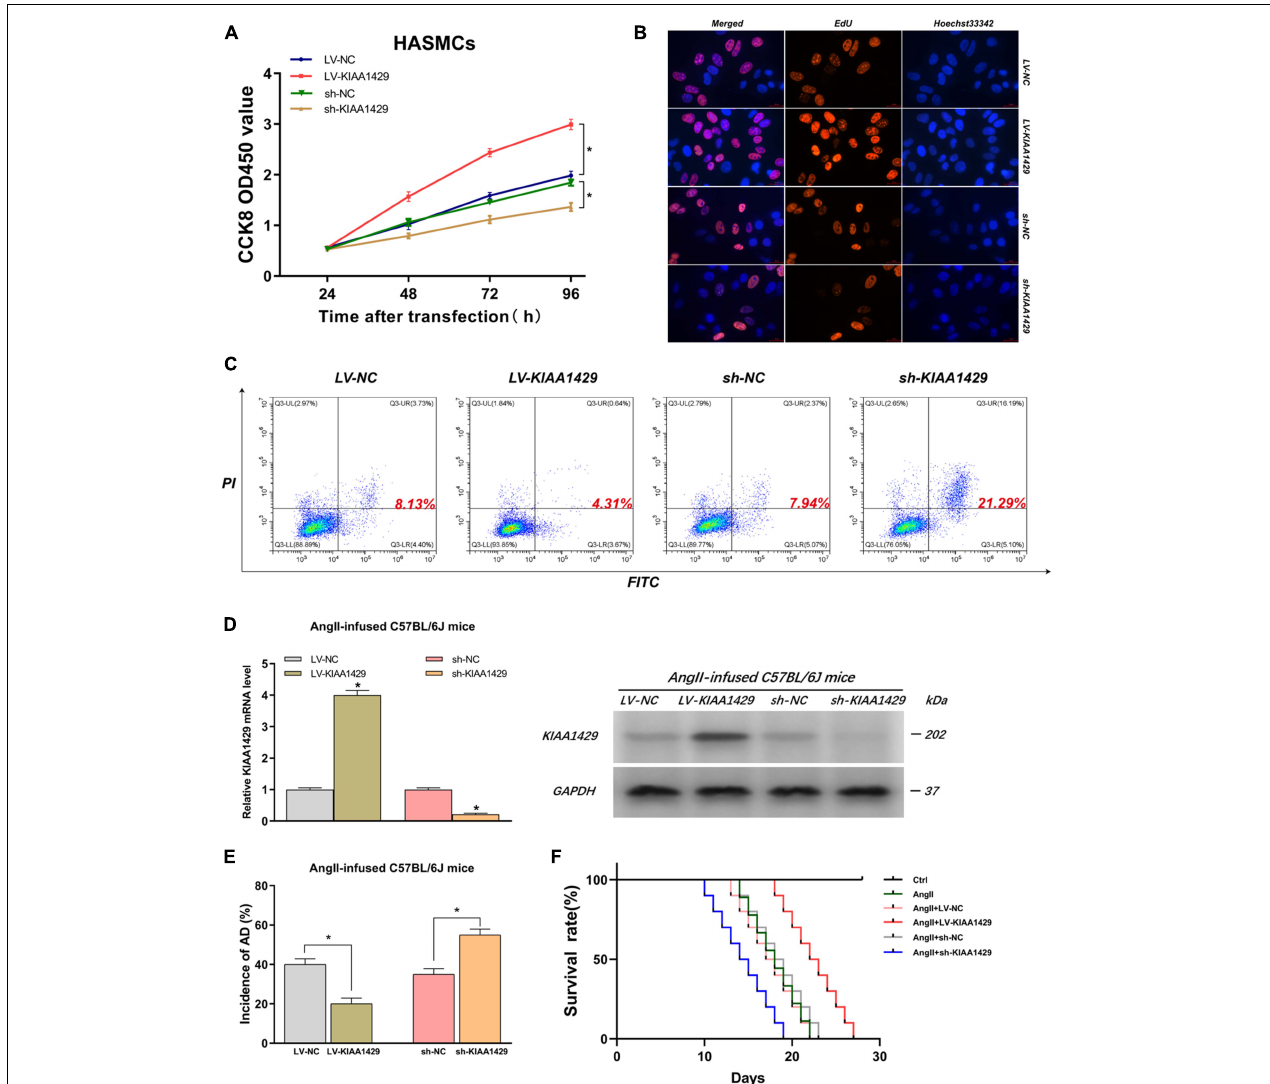
FIGURE 3 | KIAA1429 can promote HASMC proliferation, inhibit HAEC apoptosis, and inhibit AD progression in AngII-infused mice. (A,B) KIAA1429 overexpression led to markedly enhanced HASMC proliferation while its knockdown resulted in significantly decreased HASMC proliferation. (C) Flow cytometry analysis revealed that overexpression of KIAA1429 notably promoted HAEC apoptosis while knockdown of it significantly inhibited HAEC apoptosis. (D) The interference effects on KIAA1429 expression in AngII-infused C57BL/6J mice were detected by qRT-PCR and Western blot. (E) KIAA1429 overexpression reduced incidence while its knockdown increased the incidence of AD in AngII-infused mice. (F) Mice in the LV-KIAA1429 group and sh-KIAA1429 group had longer and shorter survival times compared to the control group, respectively. Data are presented as the mean ± SEM ( N ≥ 3 per group); * p <